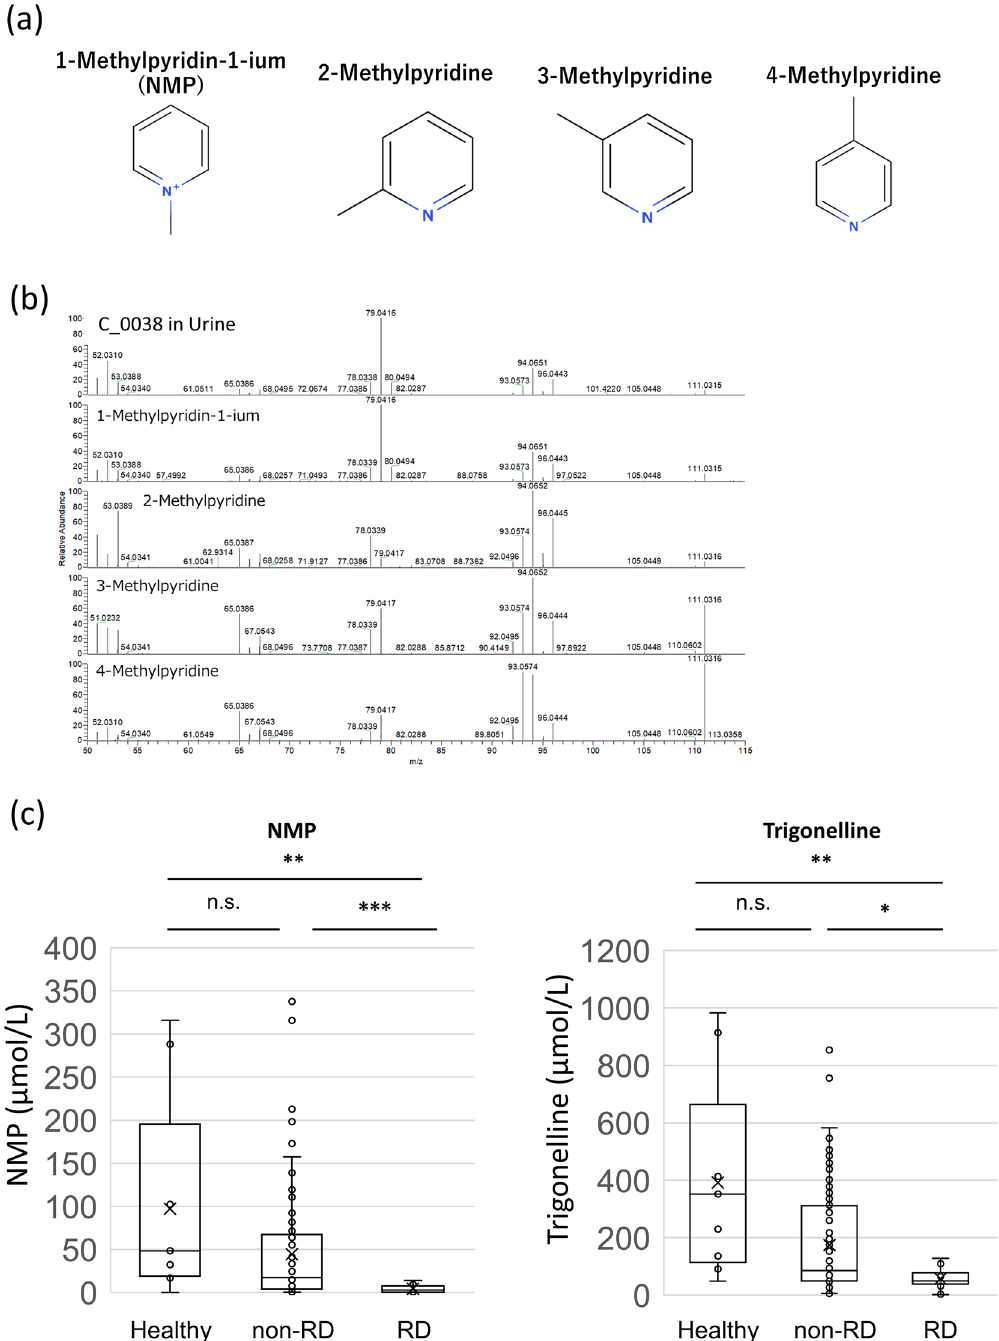
Figure 2. Identification of C_0038 as NMP, and concentration of NMP and trigonelline. ( a ) Four predicted structural formula of C_0038. ( b ) Identification of C_0038 as NMP. Result of MS/MS analysis of C_0038 in the representative human urine analyzed in this research and standard chemicals of four possible structural formula was shown (Collision Energy: 30 eV). A similar pattern was detected in the C_0038 and 1-methylpyrydin-1-ium (NMP). Human healthy urine samples were obtained from BioIVT (U.S.) ( c ) Urinary concentration of NMP and trigonelline. Urinary concentration of NMP (upper) and trigonelline (lower) was measured in healthy subjects, patients with diabetic kidney disease who were not rapid decliners, and rapid decliners among diabetic kidney disease patients. Data indicated by Tukey box plot. * p < 0.05, ** p < 0.01, *** p < 0.005, n.s. not significant (Kruskal–Wallis test). RD rapid